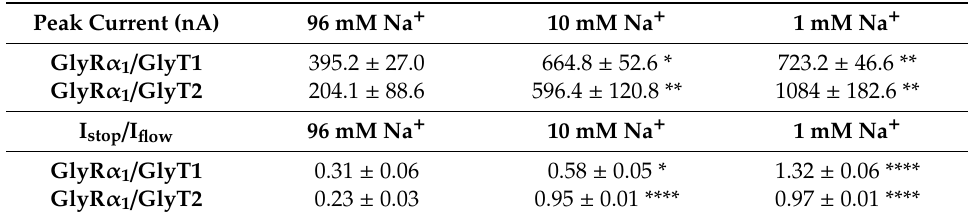
1 /GlyT co-expressed cells